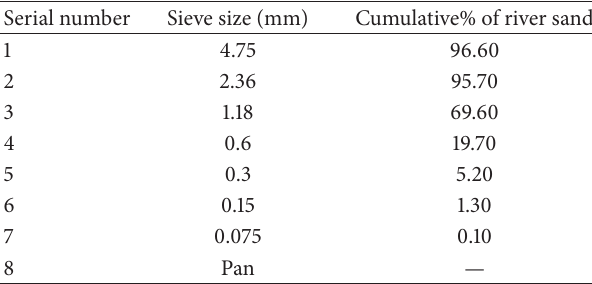
Table 2: Sieve analysis of river